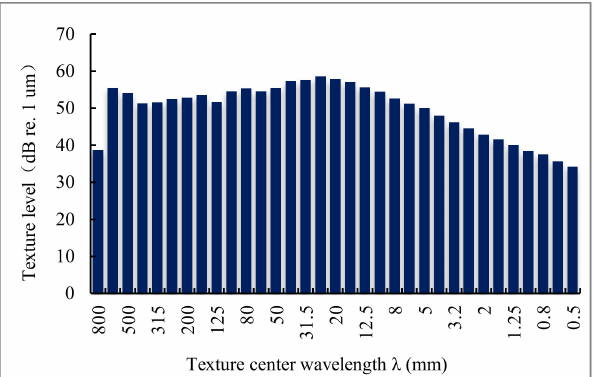
Figure 2. An example of a texture third-octave band spectrum (test site 1, a very rough chip seal). In this study, 95 % confidence limits were within ± 1.5 dB in the range 2–100 mm and within ± 2.5 dB at the longer and shorter